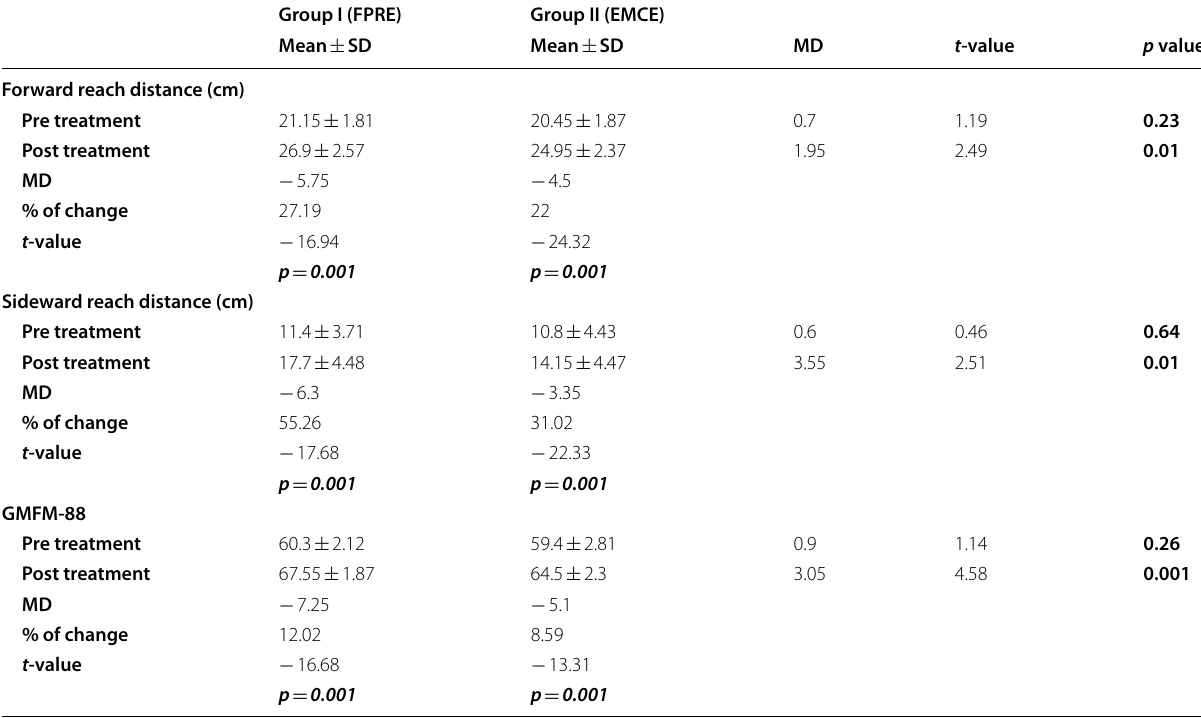
SD standard deviation, MD mean difference, p-value level of